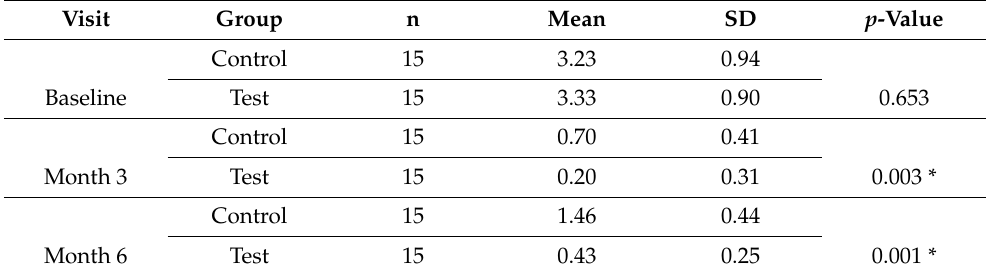
Table 2. Inter-group comparison of gingival recession